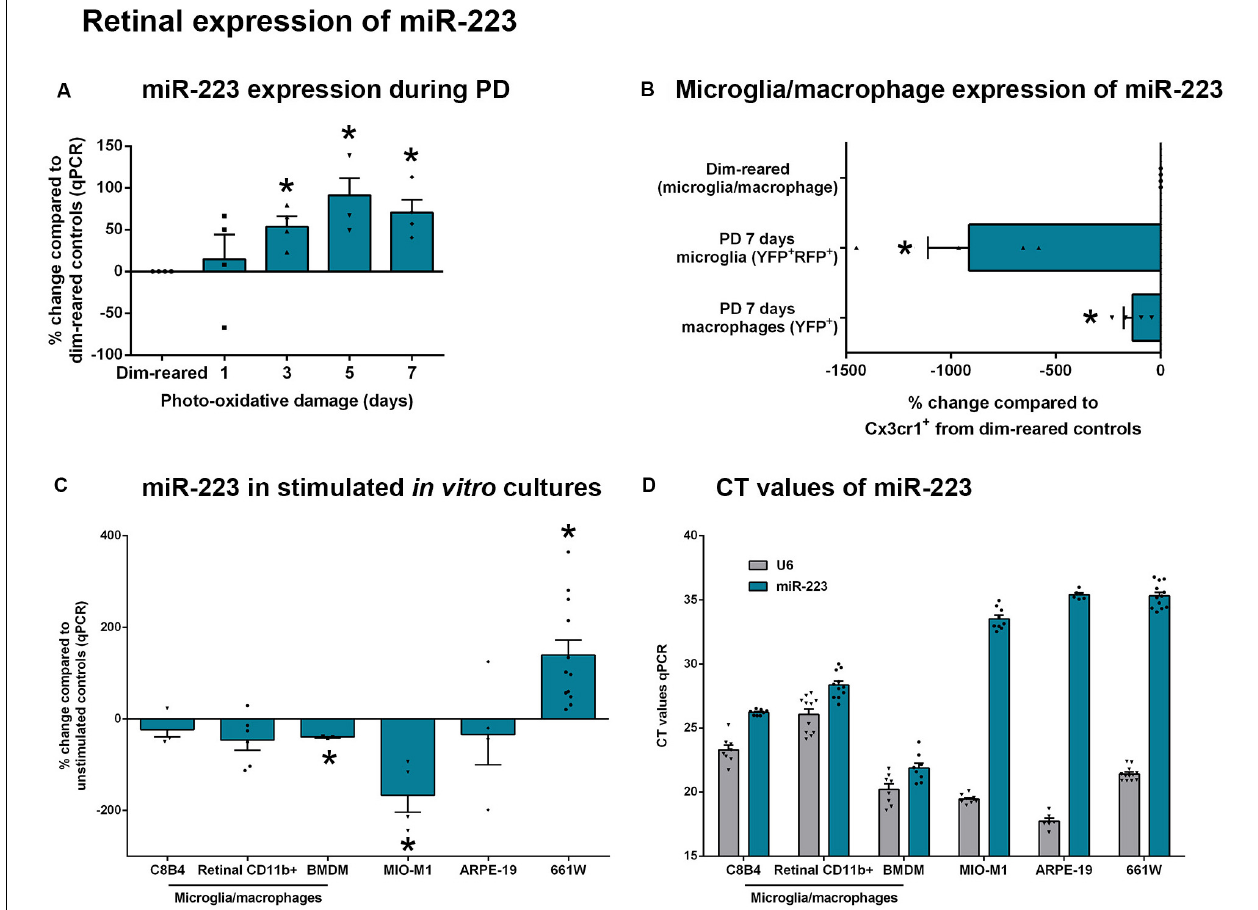
FIGURE 2 | Retinal expression of miR-223 during stimulation. (A) During photo-oxidative damage (PD) in wild-type (WT) mice, miR-223 in the retina is significantly upregulated between 3 and 7 days, peaking at 5 days ( P < 0.05), compared to dim-reared control levels. (B) Compared to dim-reared microglia/macrophages (Cx3cr1 + cells), isolated microglia (YFP + RFP + ) and macrophages (YFP + ) from 7-day PD mice had significantly reduced miR-223 levels ( P < 0.05). (C) BMDMs and MIO-M1 cells had significantly reduced miR-223 after stimulation in culture, whereas 661W cells showed an increase in miR-223 ( P < 0.05). C8B4 cells, retinal CD11b + cells, and ARPE-19 cells showed no change in the expression of miR-223 between conditions ( P > 0.05). (D) When comparing the CT values of miR-223 and U6 (reference) across cell types in both unstimulated and stimulated conditions, it is shown that microglia/macrophages have a higher expression of miR-223 (lower CT) relative to other cell types (higher CT of 34–36 indicates low expression of miR-223). Sample size is N = 3–12. *Denotes significance ( P <